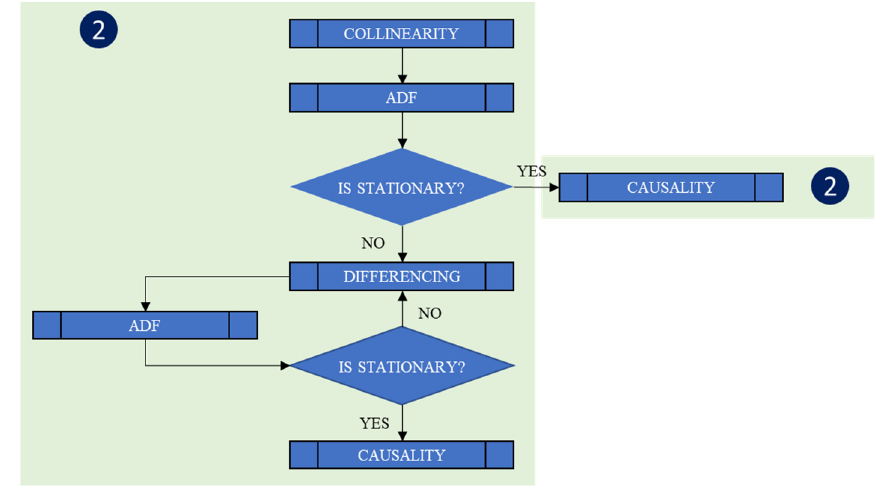
Figure 5. Flow chart to choose the input variables (Step 2).